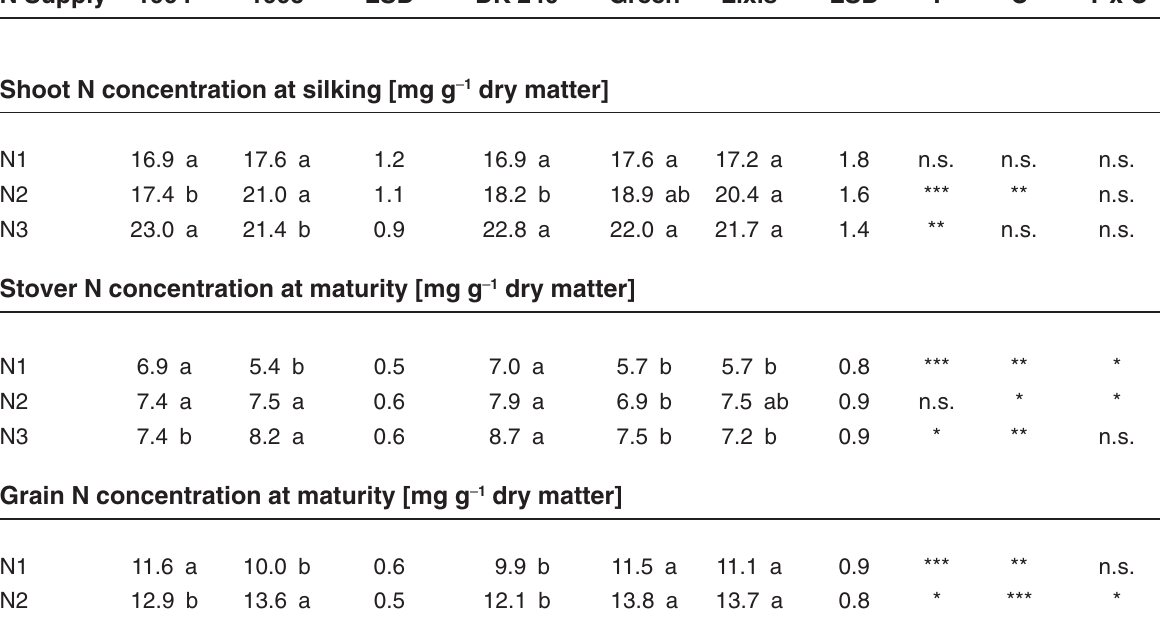
N Concentration in Shoot Dry Matter at Silking, and in Straw and Grain Dry Matter at Maturity of Maize as Influenced by Year (Y), Cultivar (C), and N Supply